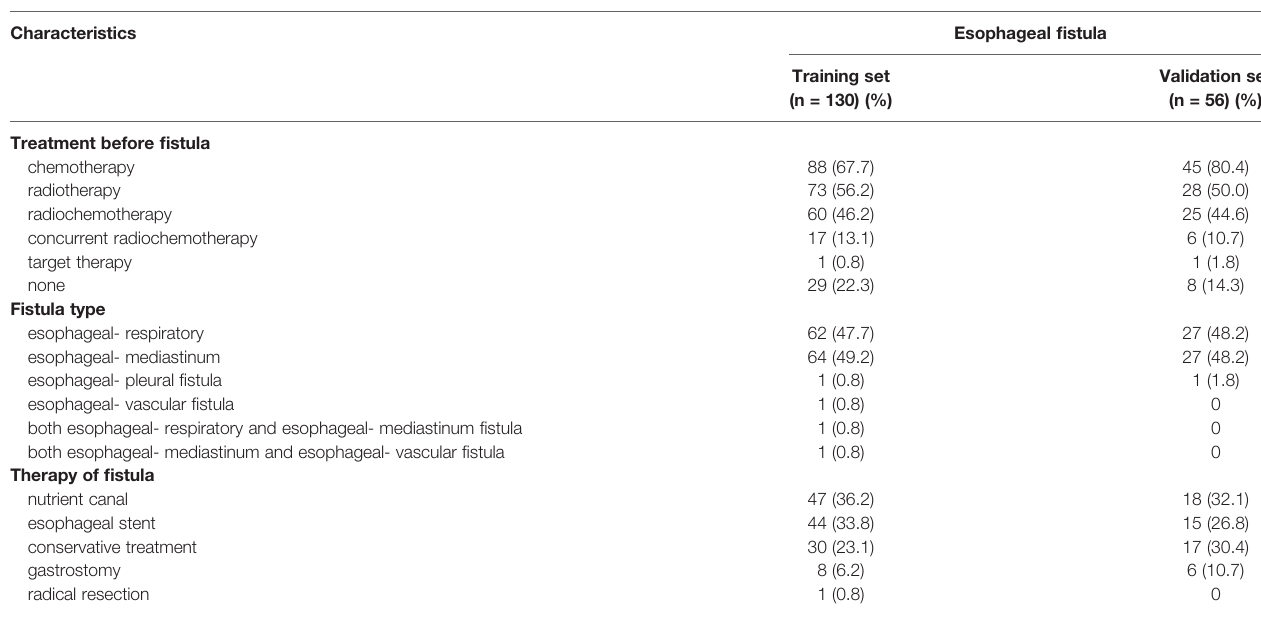
TABLE 2 | Esophageal fi stula characteristics of the patients.